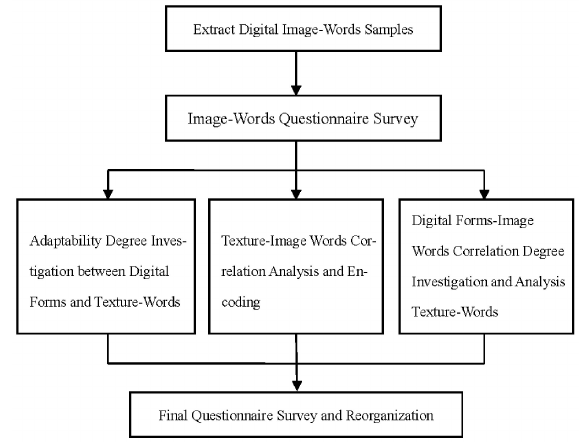
Figure 2. The flow chart of affective engineering